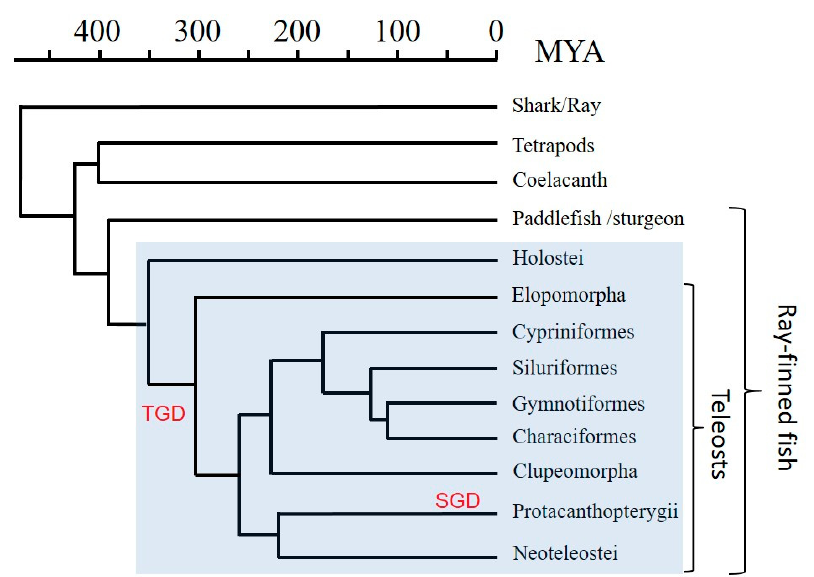
Figure 1. Phylogeny of the fish clades investigated in this study according to Near et al. [46]. A timescale is depicted in millions of years ago (MYA) above the figure. As for the investigated fish species: Holostei include bowfin and spotted gar; Elopomorpha include European eel and American eel; Cypriniformes include common carp, zebrafish, and horned golden-line barbel; Siluriformes include channel catfish, blue catfish, southern catfish, and amur catfish; Gymnotiformes include glass knifefish; Characiformes include Mexican tetra, tambaqui, and pacu; Clupeomorpha include Atlantic herring, Hilsa ilisa, sardine, and allis shad; Protacanthopterygii include Atlantic salmon, rainbow trout, coho salmon, and Northern pike; and Neoteleostei include Nile tilapia, stickleback, tetraodon, yellow croaker, red-lip croaker, guppy, medaka, and turquoise killifish. Clades possessing HAA gene sequences are boxed in blue. The teleost specific third whole genome duplication (TGD) and the salmonid specific fourth whole genome duplication (SGD) are shown.